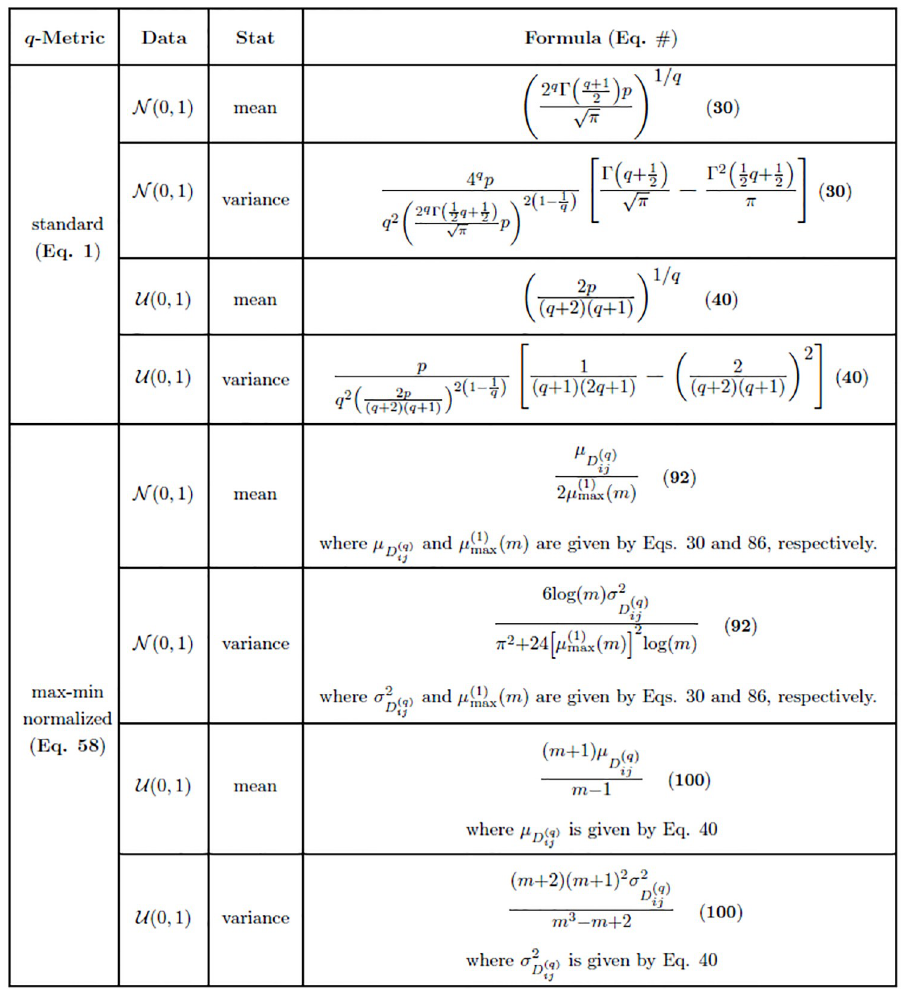
Fig 2. Summary of distance distribution derivations for standard normal ( N ð 0 ; 1 Þ ) and standard uniform ( U ð 0 ; 1 Þ ) data. Asymptotic estimates are given for both standard (Eq 1) and max-min normalized (Eq 58) q-metrics. These estimates are relevant for all q 2 N and p � 1 for which the normality assumption of distances